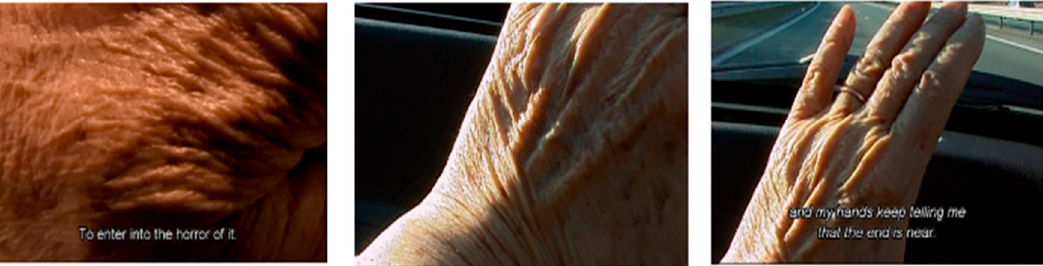
Figure 5. In a curious blend of mobility and movement, Varda films her hand by holding it steadily against the background of fast-moving vehicles.